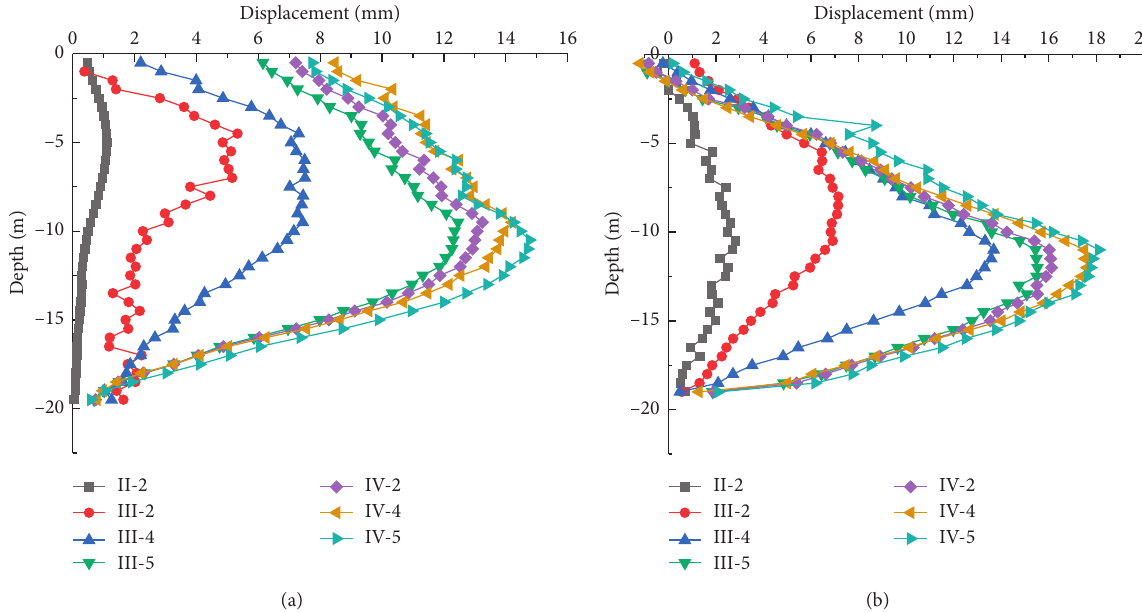
Figure 6: Monitoring results of the lateral wall displacement at (a) H12 and (b) H35 during the PIP